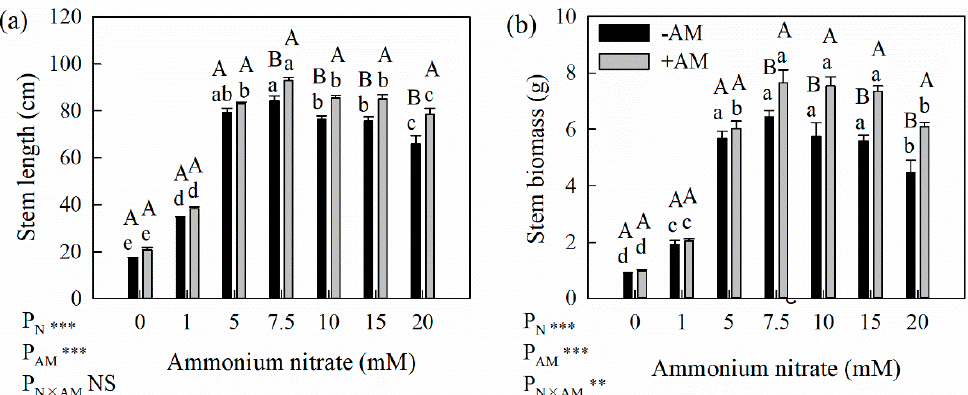
Figure 1. E ff ects of AM fungi on stem length ( a ) and stem biomass( b ) of poplar seedlings under Figure 1. Effects of AM fungi on stem length (a) and stem biomass(b) of poplar seedlings under di ff erent N application levels. *significant e ff ect at p < 0.05; **significant e ff ect at p < 0.01; ***significant different N application levels. *significant effect at p < 0.05; **significant effect at p < 0.01; ***significant e ff ect at p < 0.001; NS: no significant e ff ect. Values are presented as the means ± SE (n = 10). Di ff erent